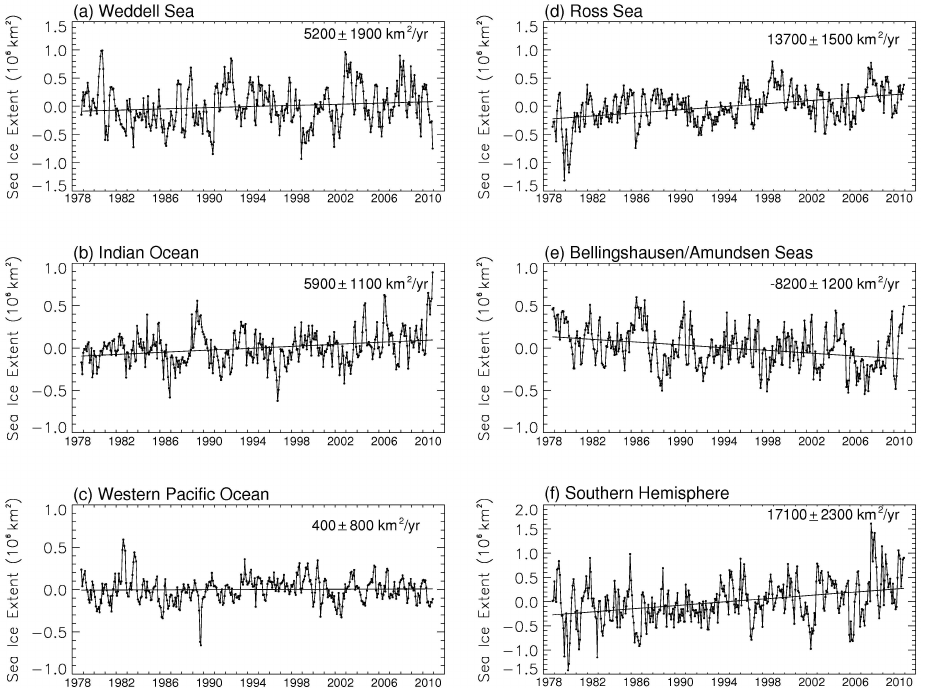
Fig. 4. Sea ice extent monthly deviation plots, November 1978 through December 2010, calculated from SMMR, SSMI, and SSMIS satellite data, for the following regions and hemispheric total: (a) Weddell Sea, (b) Indian Ocean, (c) western Pacific Ocean, (d) Ross Sea, (e) Bellingshausen/Amundsen Seas, and (f) Southern Hemisphere as a